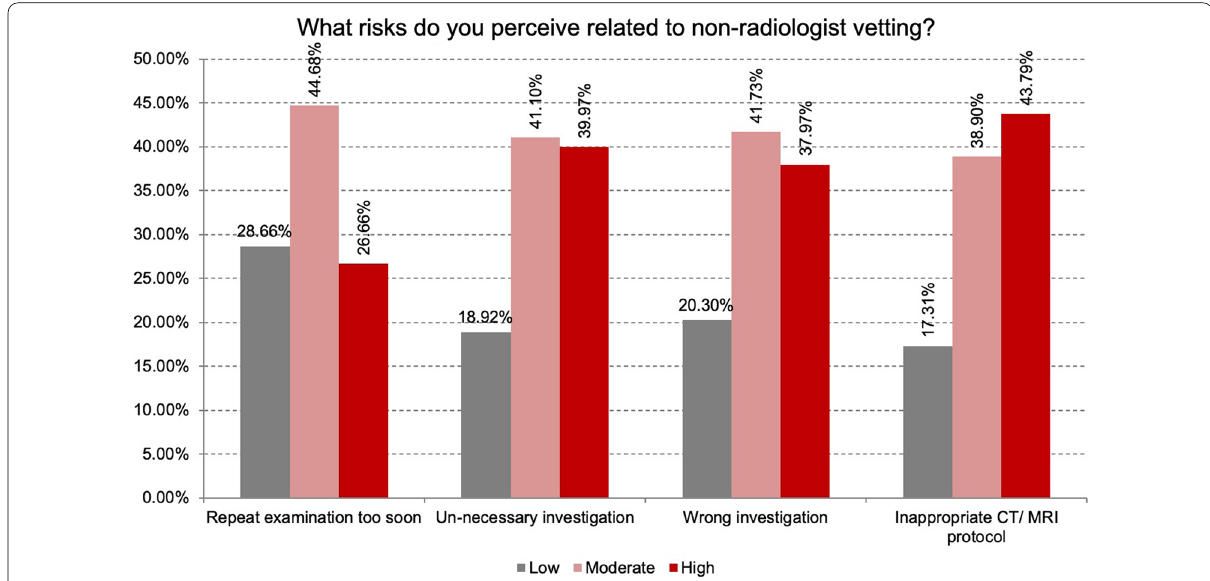
Fig. 16 What risks do you perceive related to non-radiologist vetting? (responses n